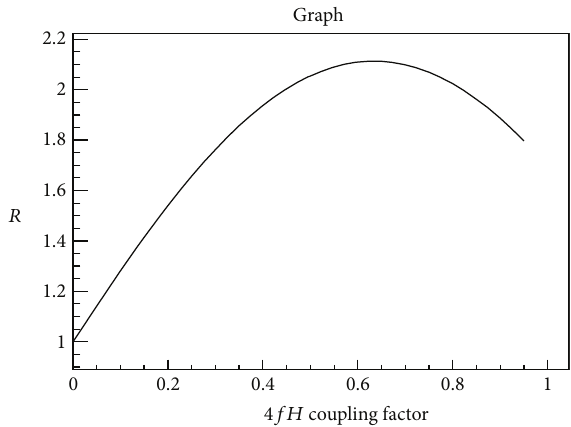
Figure 5: The dependence of the ratio 𝑅 on the suppression factor,